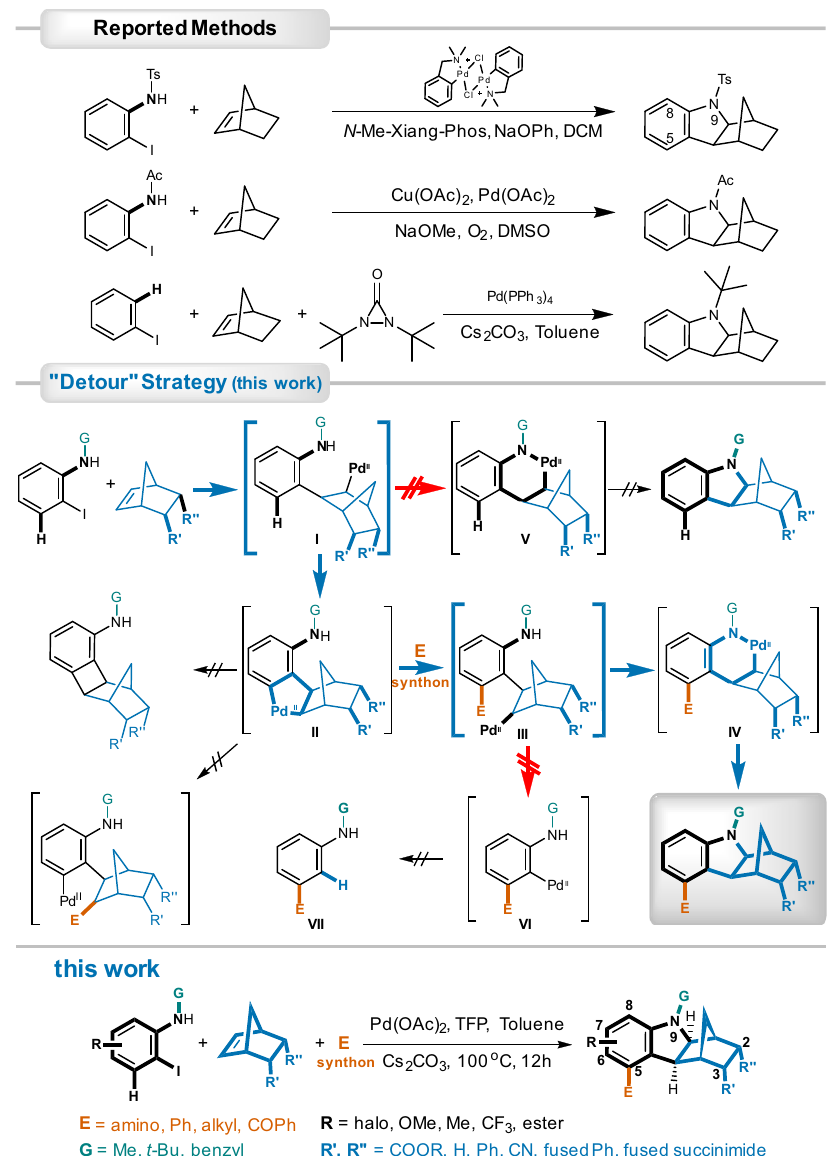
Fig. 2 Strategies and methods in synthesizing hexahydro-1,4-methanocarbazole ring. Traditional methods involved palladium-catalyzed direct condensation, or electrophilic insertion by external amine surrogates. In contrast, “ detour ” strategy in this work employed successive generation of two key phenylnorbornyl palladium species to construct the hexahydro-1,4-methanocarbazole core and introduce 5-substitution in tandem. Ligands to Pd II , and electrophile-Pd IV complexes were omitted when illustrating for the sake of